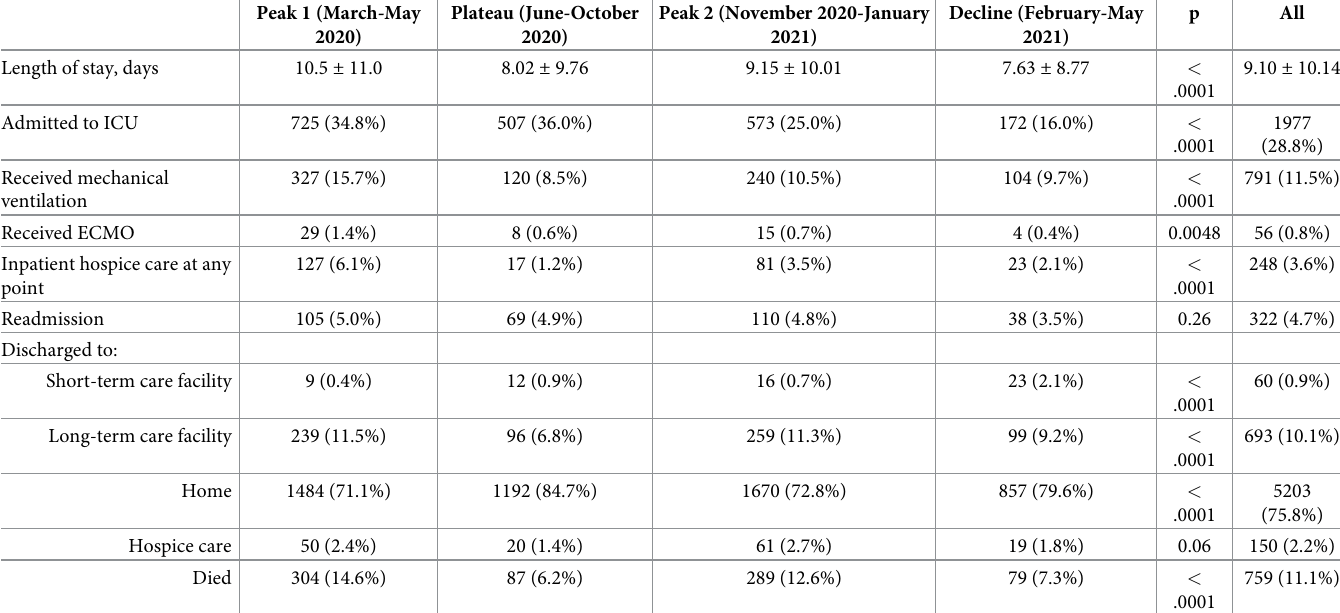
Table 3. Resource utilization and outcomes of COVID-19 patients admitted to Inova Health System